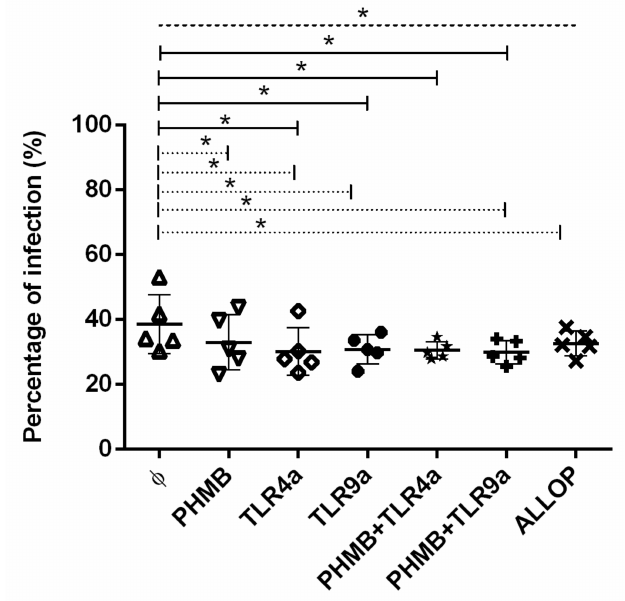
Figure 1. Percentage of in vitro L. infantum infected macrophages after 24 h treatment with the di ff erent conditions: Medium alone (Ø), Polyhexamethylene biguanide alone (PHMB), MPLA Toll-like receptor agonist 4 (TLR4a), PHMB plus TLR4a (PHMB + TLR4a), CpG ODN Toll-like receptor agonist 9 (TLR9a), PHMB plus TLR9a (PHMB + TLR9a), and allopurinol (ALLOP). Significant results are described as * 0.05 > p > 0.01. Lines in graphic represent ANOVA (dashed lines), Dunnett’s test (solid lines), and Wilcoxon signed-rank test (dotted